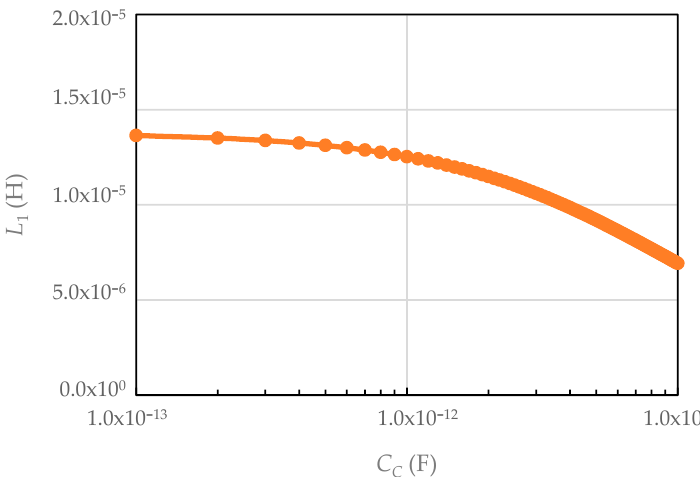
Figure 12. Inductor value L 1 for various ratios of the coupling capacitance C C .